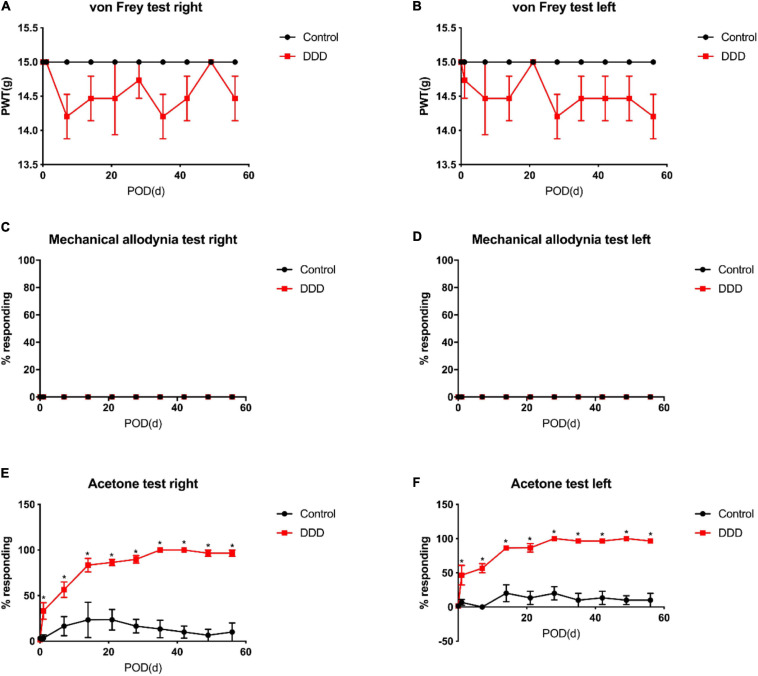
The mechanical pain and cold response of animals. Panel (A) is the result of von-Frey of the right lower limb of the rat. Panel (B) is the result of the von-Frey of the left lower limb of the rat. Panel (C) is the result of the tactile response of the right lower limb of the rat. Panel (D) is the result of the tactile response of the left lower limb of the rat. Panel (E) is the result of the cold response of the right lower limb. Panel (F) is the result of the cold response of the left lower limb of the rat; all data are expressed as mean ± standard deviation, *P < 0.05 vs. DDD group (n = 5). PTW, paw withdrawal threshold; POD, post-operation days.